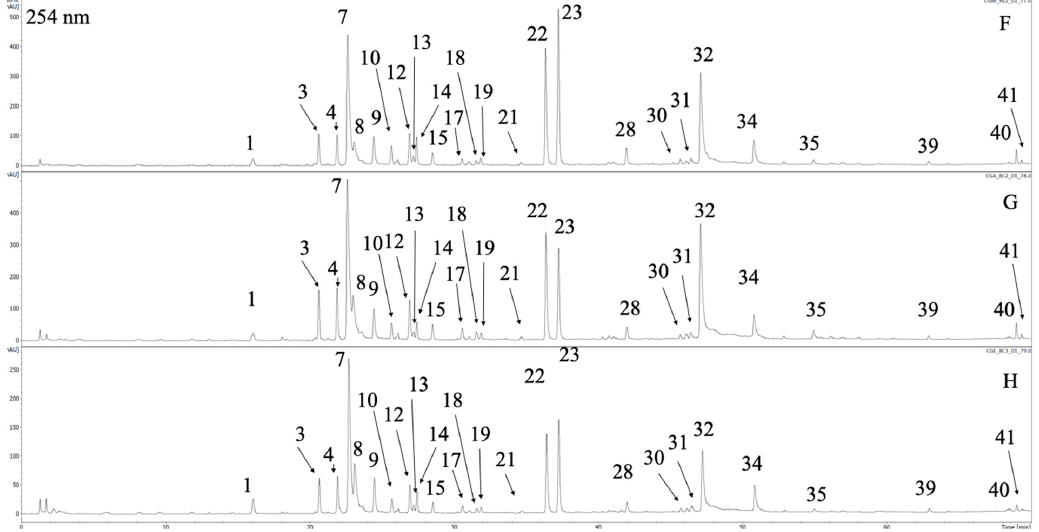
Figure 2. The LC-DAD chromatogram of C. gigantea acquired at 254 nm with marked